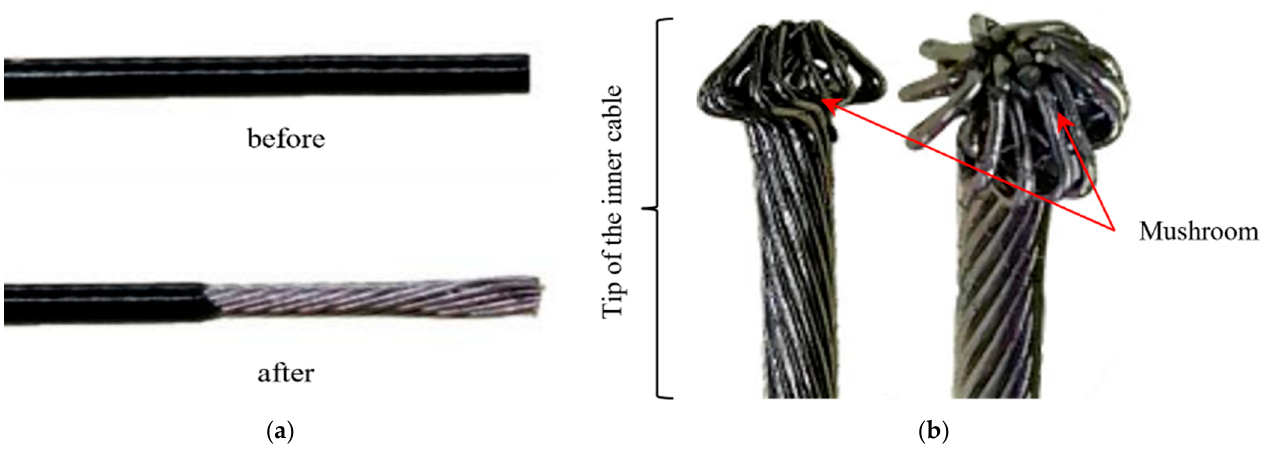
Figure 3. Preparation processes to the control cables: ( a ) removal of the plastic cover to the cable, ( b ) mushrooming of the inner cable’s tip.